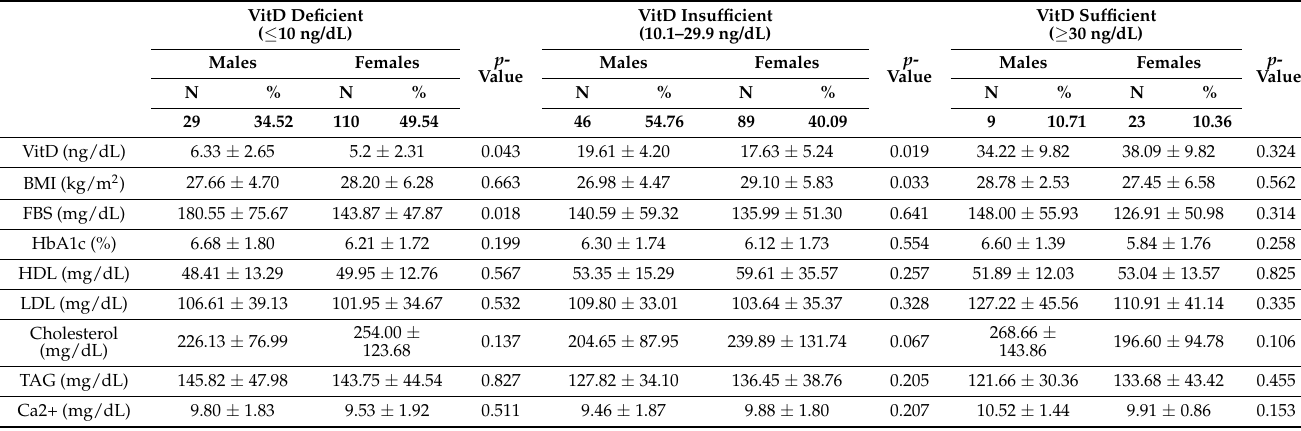
Table 1. VitD status and other health indicators in Libyan young adults (18–25 years) according to the VitD cut-off groups and